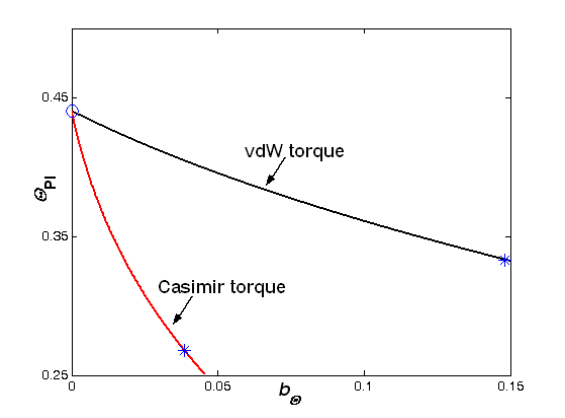
Figure 5. Comparison between vdW and Casimir torques with variation of the pull-in angle